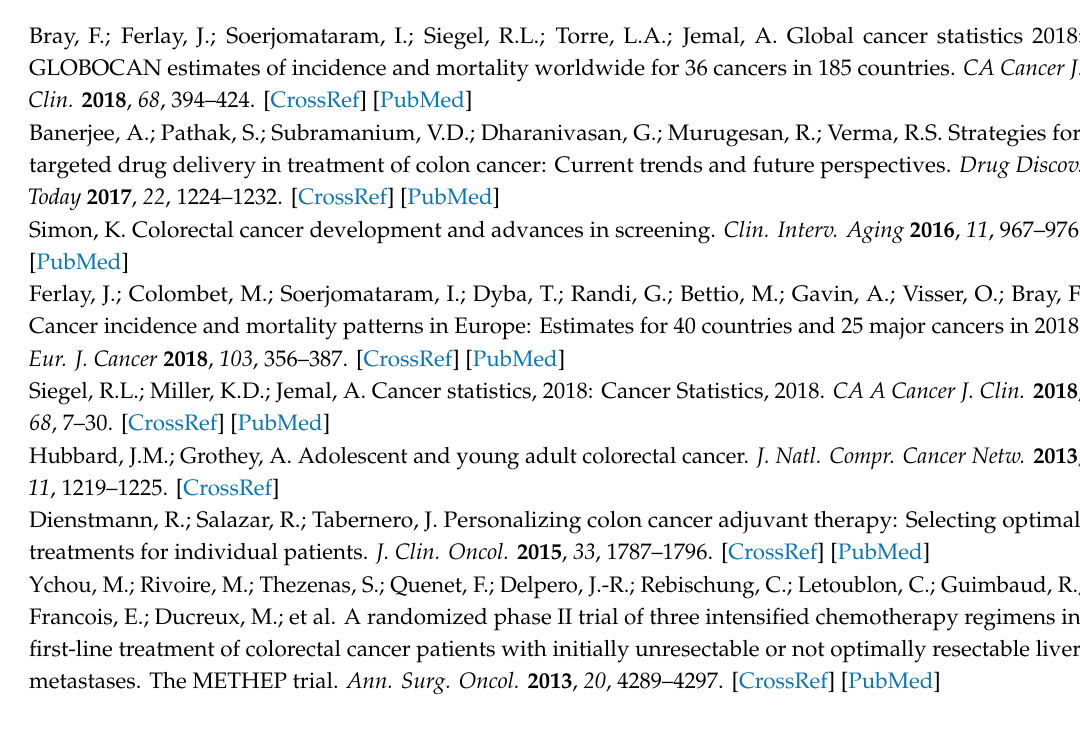
Figure S1: Comparative magnetic migration assay of T-84 (A), SW840 (B), and HT29 (C) colon cancer cells exposed to di ff erent concentrations of BMNPs and Fe and stained with SRB. Migration of the cells after treatments was evaluated in the presence or absence of a